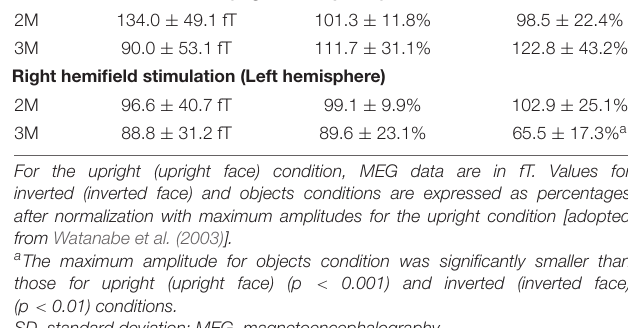
TABLE 3 | Mean and SD of the maximum amplitude of 2M and 3M components contralateral to the stimulated hemifield. Upright Inverted Objects Left hemifield stimulation (Right hemisphere)